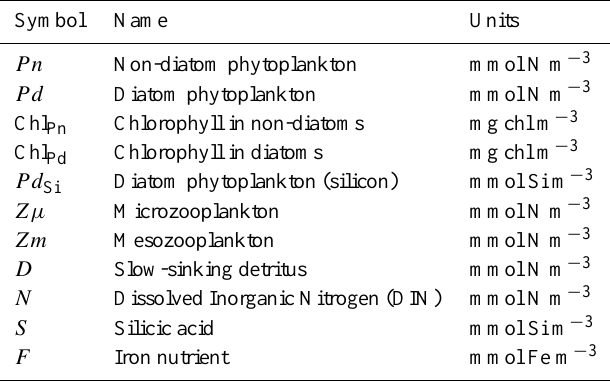
Table 2. Model state variables.